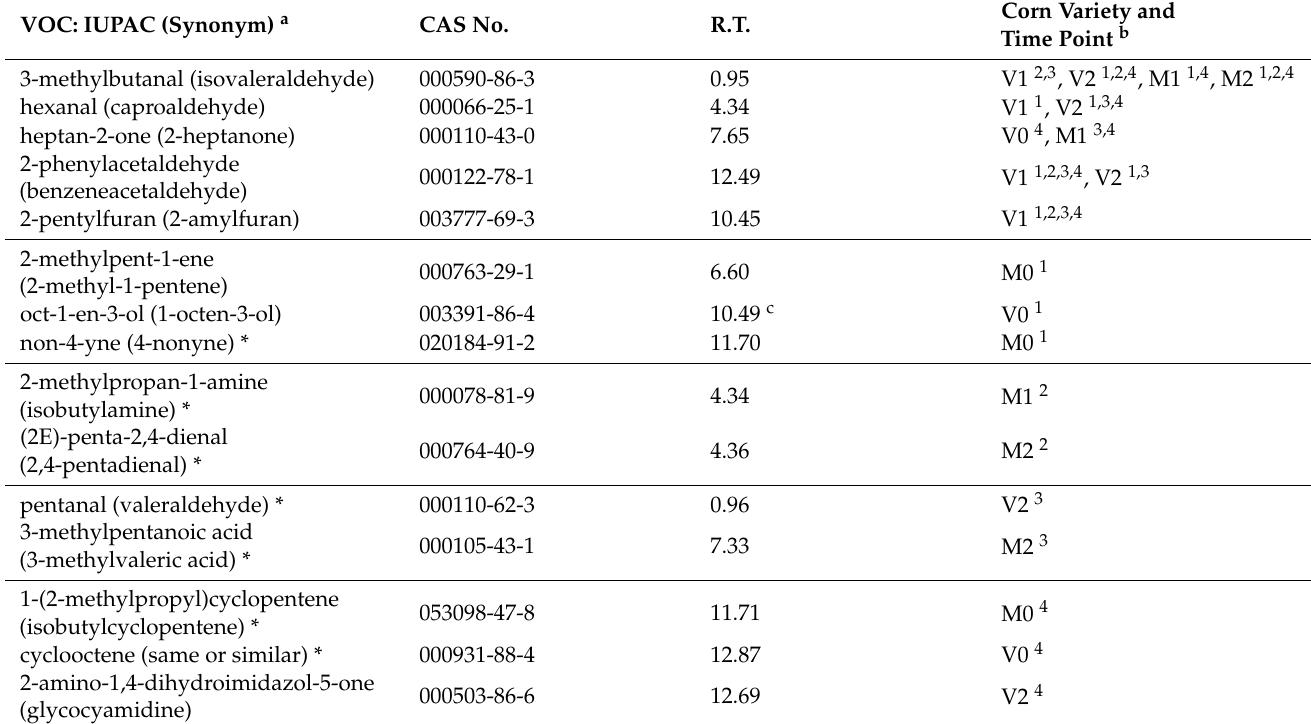
Table 2. Headspace VOC profiles for multiple Aspergillus strains while growing on two different corn varieties over two